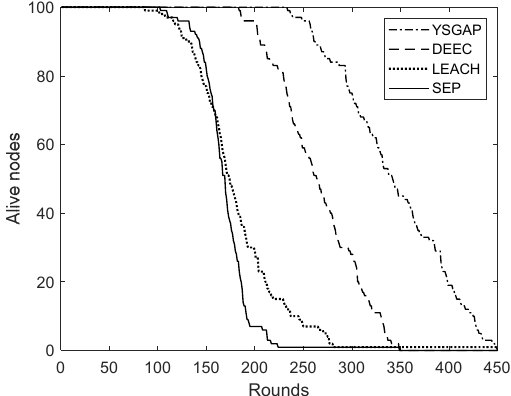
Figure 1. Network lifetime: alive nodes history.